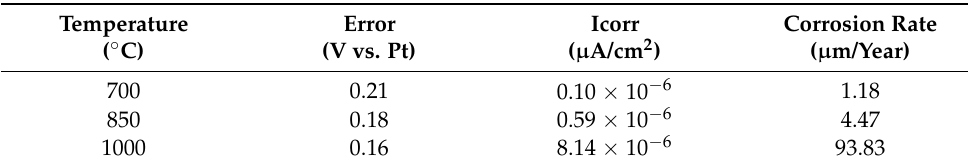
Table 3. The corrosion potential, current density, and corrosion rate obtained for Bi 3 La 1 Ti 3 O 12 at 700 ◦ C, 850 ◦ C, and 1000 ◦